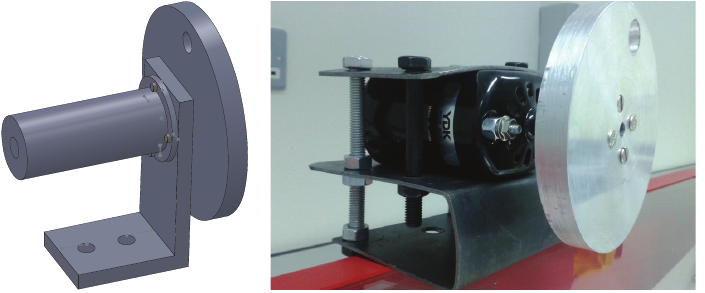
Figure 4: The unbalanced rotor-motor